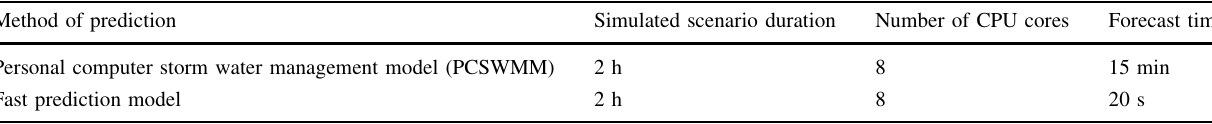
Table 6 Comparison of the time required for different stagnant water prediction methods Method of